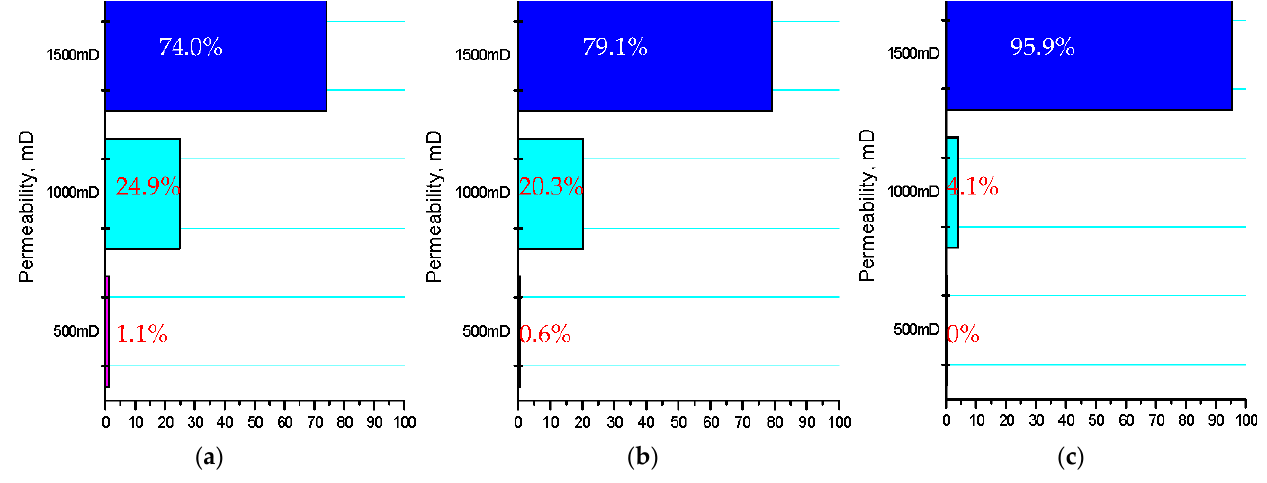
Figure 7. Liquid rate proportion at different steam injection periods. ( a ) 4.7 h ( b ) 8.0 h ( c ) 11.3 h.